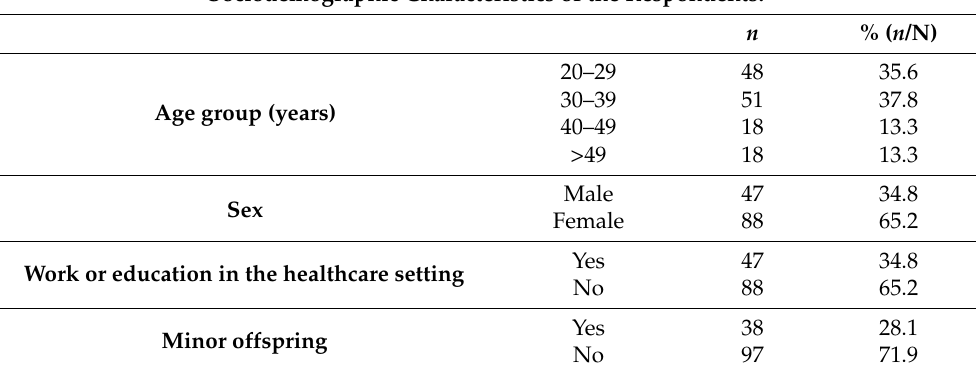
Table 1. Sociodemographic characteristics of respondents ( n = 135). Sociodemographic Characteristics of the